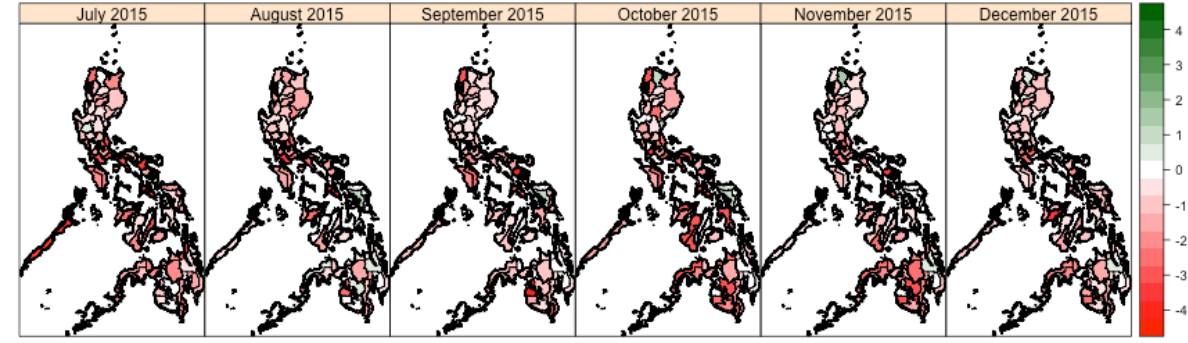
Figure 5. SVTR forecast from July to December 2015.